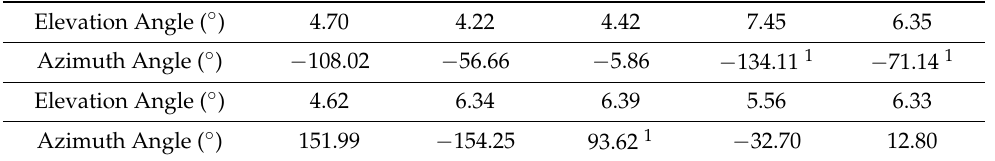
Table 10. DOA estimation of nearby inner race by UCMA-ESPRIT for rolling element fault signal at 290 rpm.